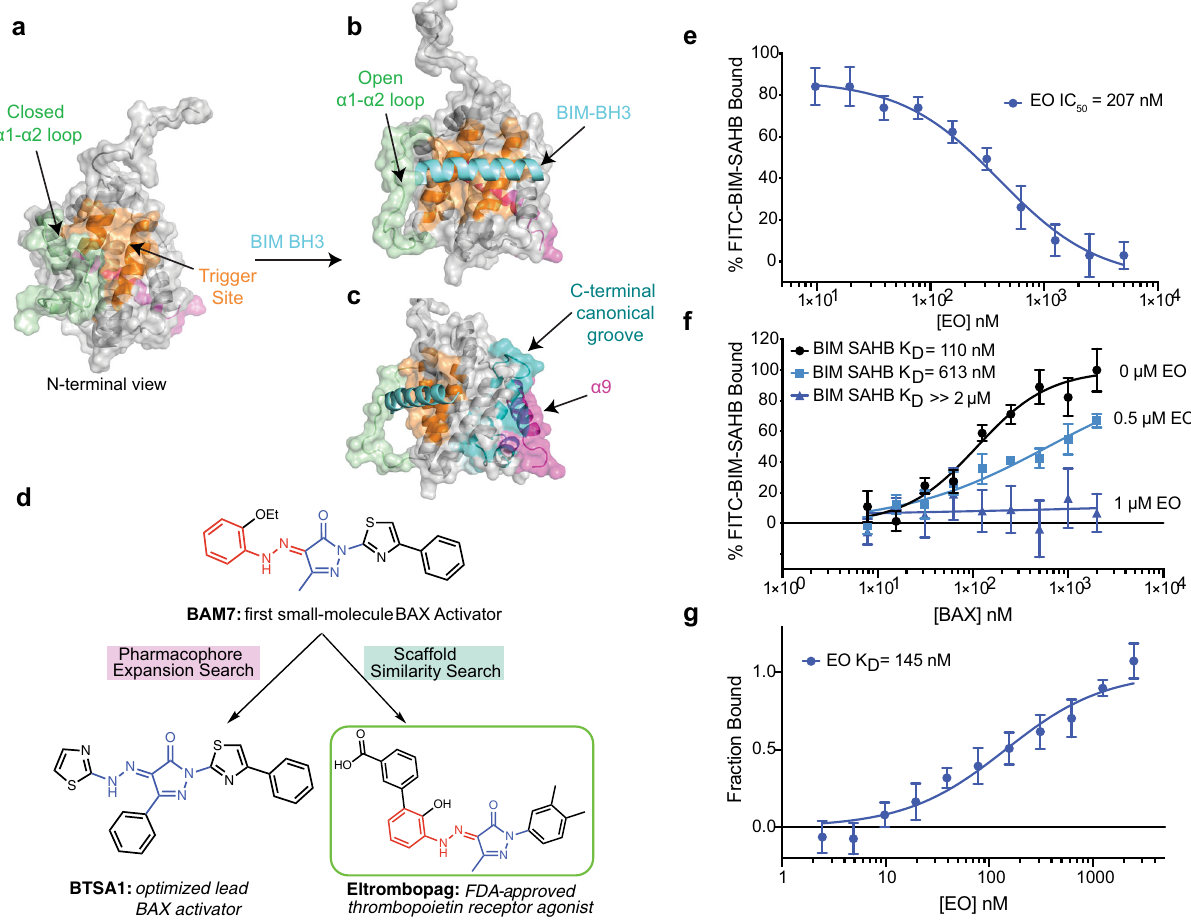
Fig. 1 Eltrombopag potently binds BAX. a Surface representation of the inactive BAX structure (PDB 1F16: https://doi.org/10.2210/pdb1F16/pdb) showing the location of the BAX trigger site (orange) and closed α 1 – α 2 loop (green). b , c Surface representation of the BIM – BH3-bound active conformation (PDB 2K7W: https://doi.org/10.2210/pdb2K7W/pdb) showing binding of BIM – BH3 (cyan) with opened α 1- α 2 loop (green) at the trigger site ( b ) and the location of α 9 bound to the C-terminal canonical groove ( c ). d Chemical structures of BAM7, BTSA1, and EO derived by similarity search. The 3-methyl pyrazolone (blue) and phenylhydrazone (red) groups are highlighted for clarity. e Competitive fl uorescence polarization (FP) binding assay of EO. Data are representative of three independent experiments, each n = 3 ± SEM. f Binding af fi nity of FITC-BIM – SAHB to BAX by FP in the presence of EO. Data represent n = 2 ± SEM from two independent experiments. g Microscale thermophoresis direct binding of EO to BAX-4C. Data are representative of three independent experiments each n = 3 ± SEM. Source data for this fi gure is